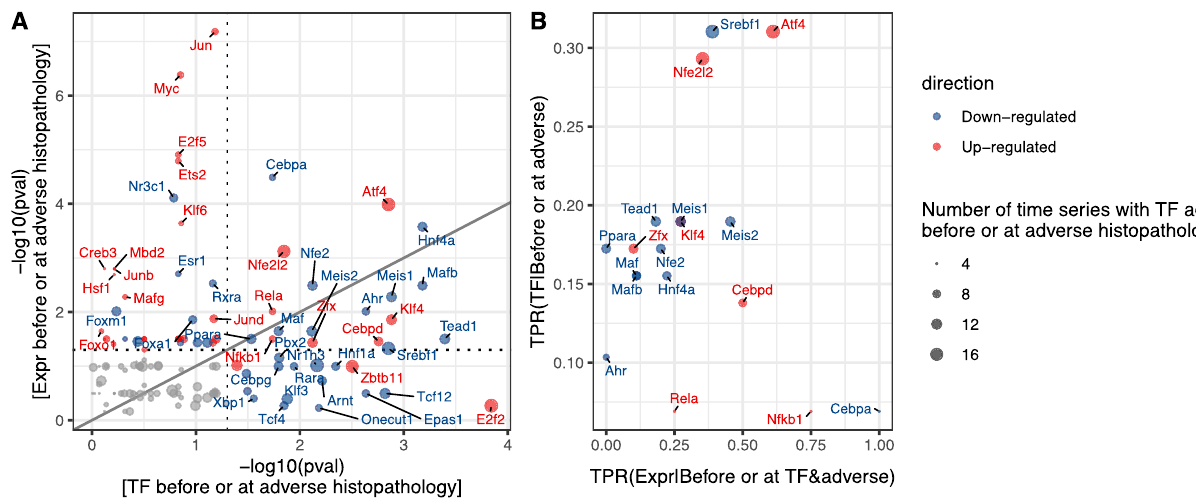
Fig 9. Transcription Factor (TF) activity and expression before adverse histopathology. A) Significance of enrichment in adverse conditions for matched TF activity and expression-based events. Events only found on the expression or TF level are not included in the figure due to the inability to perform a statistical test for those. B) For significantly enriched TF activity-based events, the True Positive Rate (TPR) of observing TF activity before or at the time of adverse histopathology is shown, as well as the TPR for observing TF expression changes before TF activity in the time series where it precedes adverse